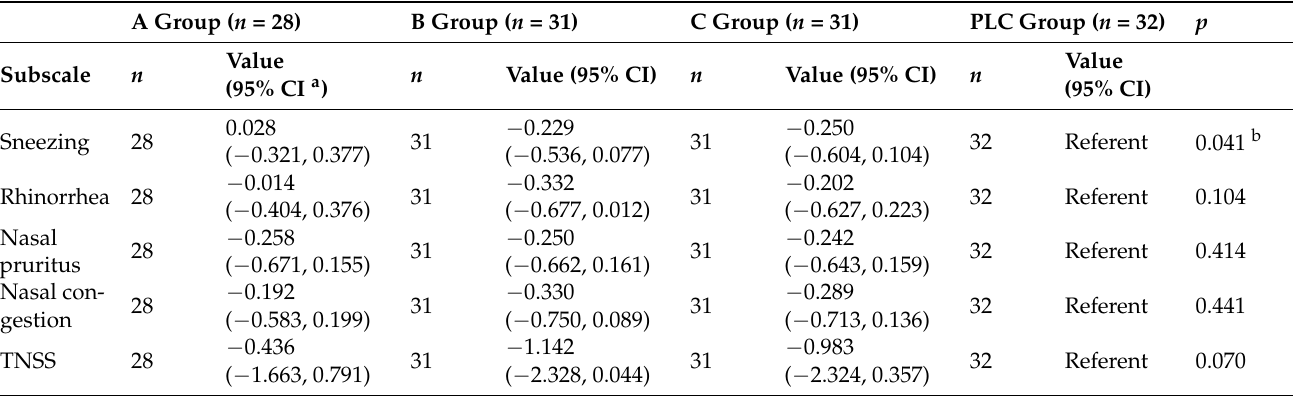
Table 5. Differences in sneezing, rhinorrhea, nasal pruritus, nasal congestion, and TNSS among the four groups after five visits based on the GEE model.